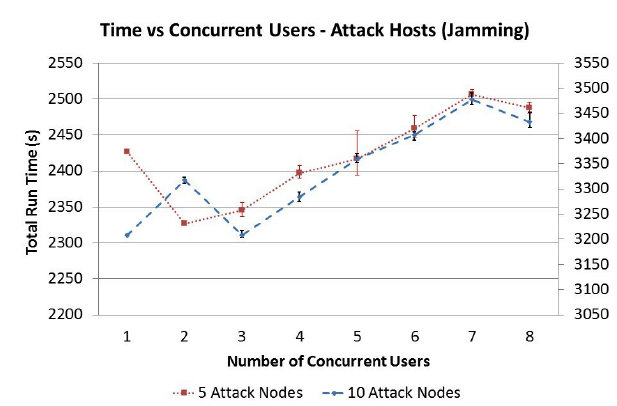
Figure 10. Run time variation of swarm simulation with increasing number of concurrent users in server mode for variable frequency bands (Jamming attack scenario)